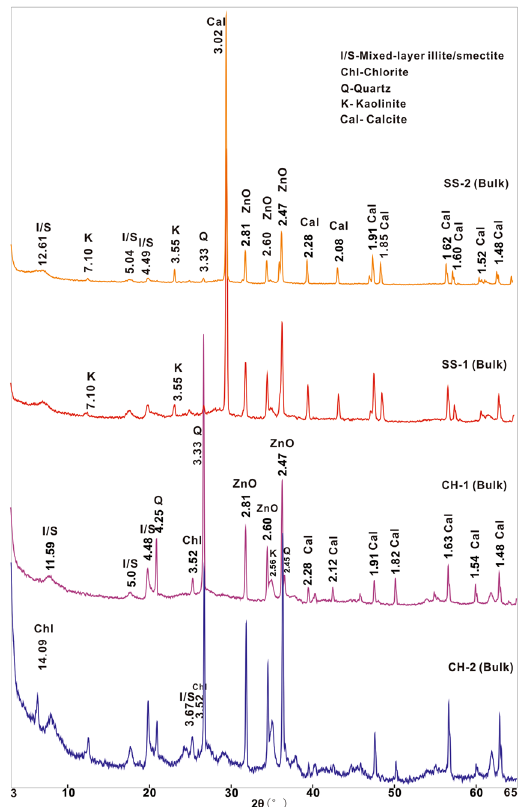
Figure 3. XRD profiles from bulk samples of Chahe and Shangsi altered ash samples.